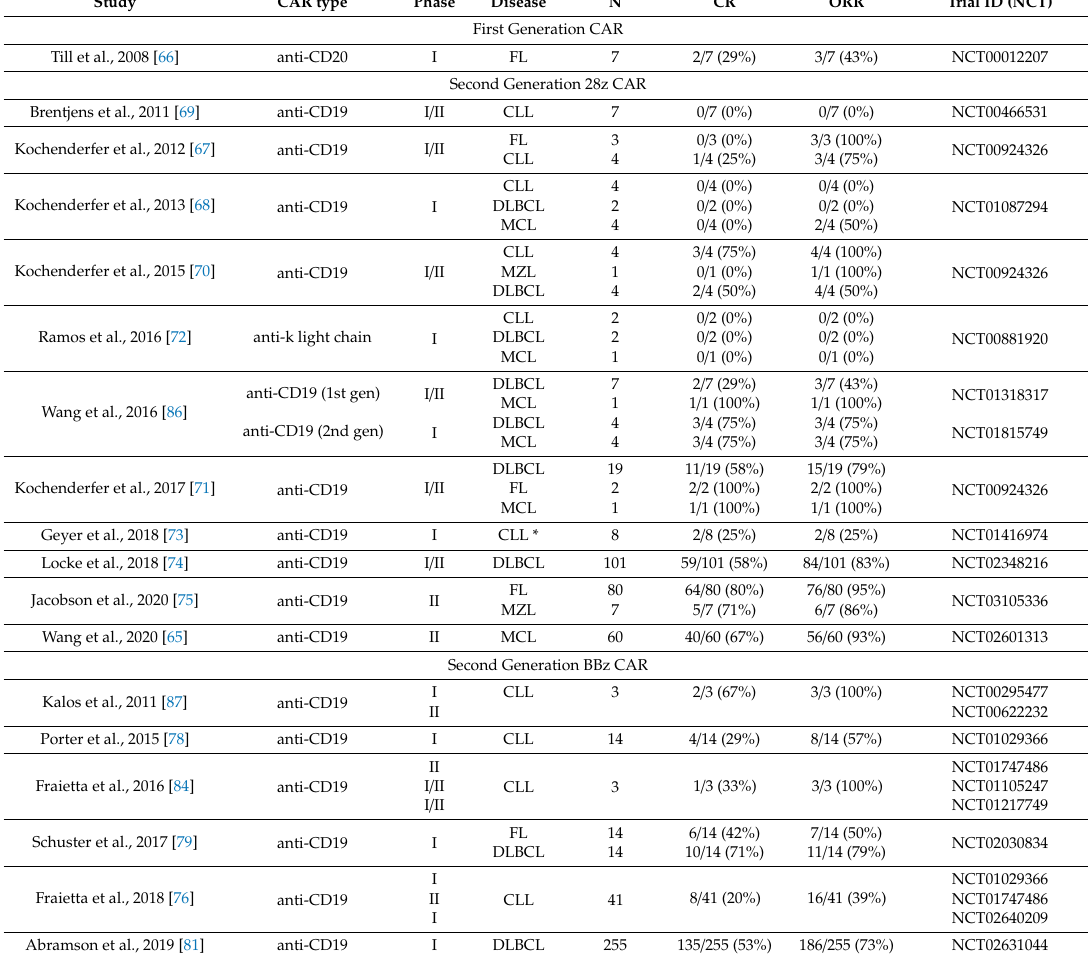
Table 3. Chimeric antigen receptor therapy clinical